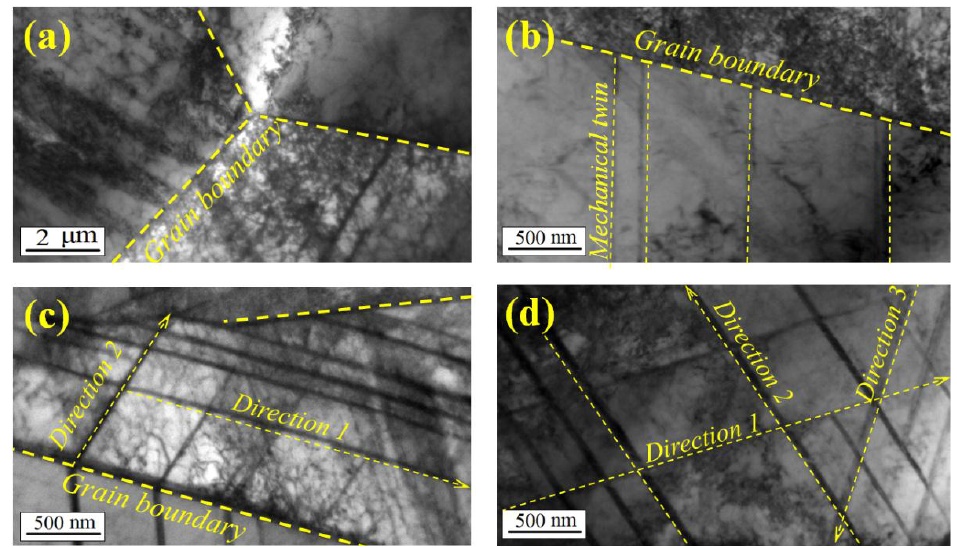
Figure 7. Typical TEM microstructures in the top surface of as-machined specimen and three types of LSPed specimens. ( a ) As-machined specimen; ( b ) single LSP impact; ( c ) dual LSP impacts; and ( d ) triple LSP impacts.